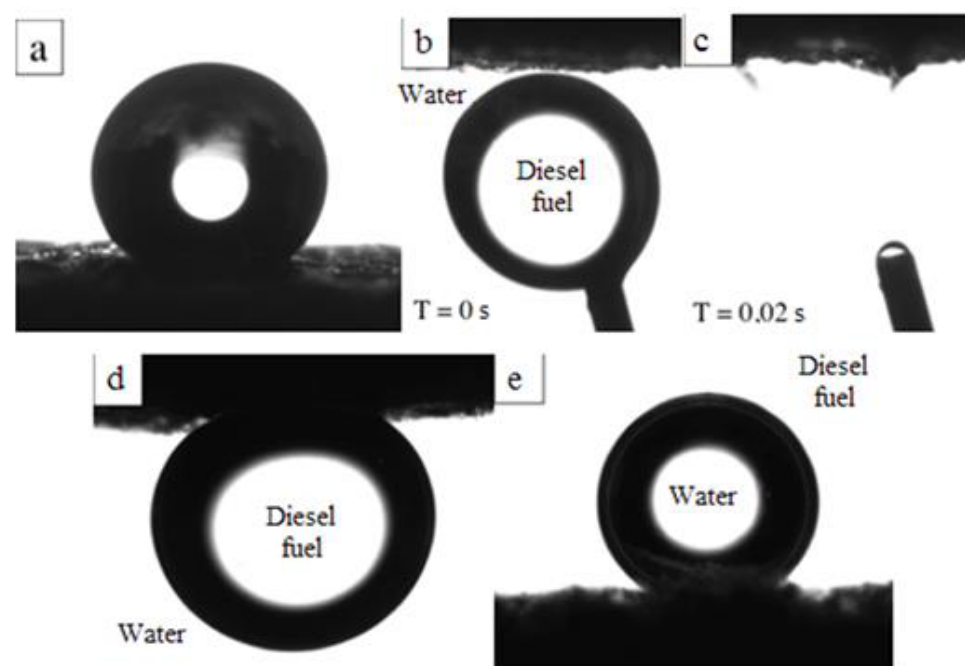
Figure 5. Images of test liquid drops in contact with the surface of chitosan aerogels: panel ( a ) shows a drop of deionized water in air medium on the surface of the chitosan aerogel modified with poly(GMA-co-DMA) copolymer; panels ( b , c ) show the process of diesel fuel drop absorption in deionized water medium by chitosan aerogel modified with poly(GMA-co-DMA) copolymer; panel ( d ) shows a drop of diesel fuel in deionized water medium on the surface of unmodified chitosan aerogel; and panel ( e ) shows a drop of deionized water in diesel fuel medium on the surface of unmodified chitosan aerogel.